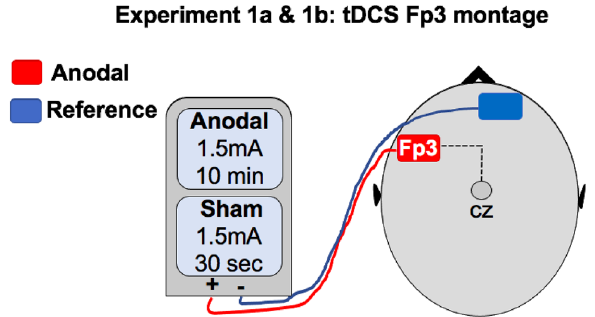
Figure 1. This illustrates the tDCS montage adopted in both Experiment 1a and 1b. This was the same tDCS montage adopted in Civile et al. 24,26 .